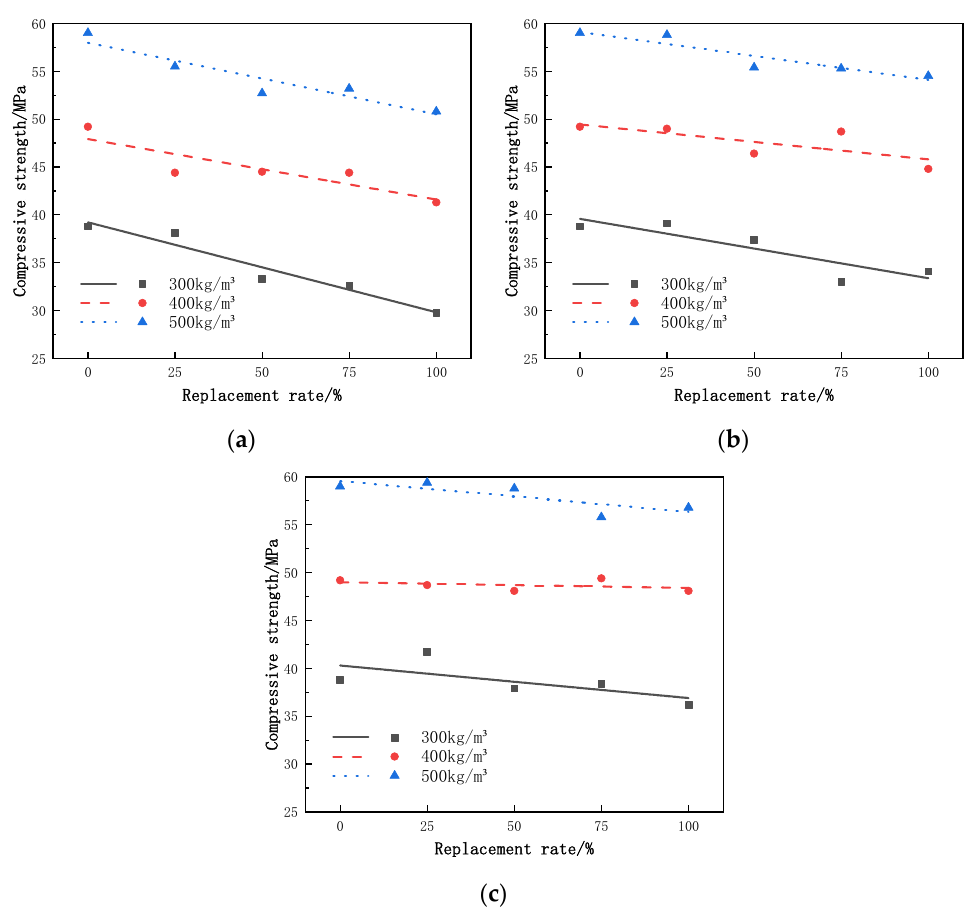
Figure 5. Effect of cementitious material content on compressive strength of RAC: ( a ) JD-HBRAC, ( b ) KL-HBRAC, and ( c ) EKL-HBRAC.